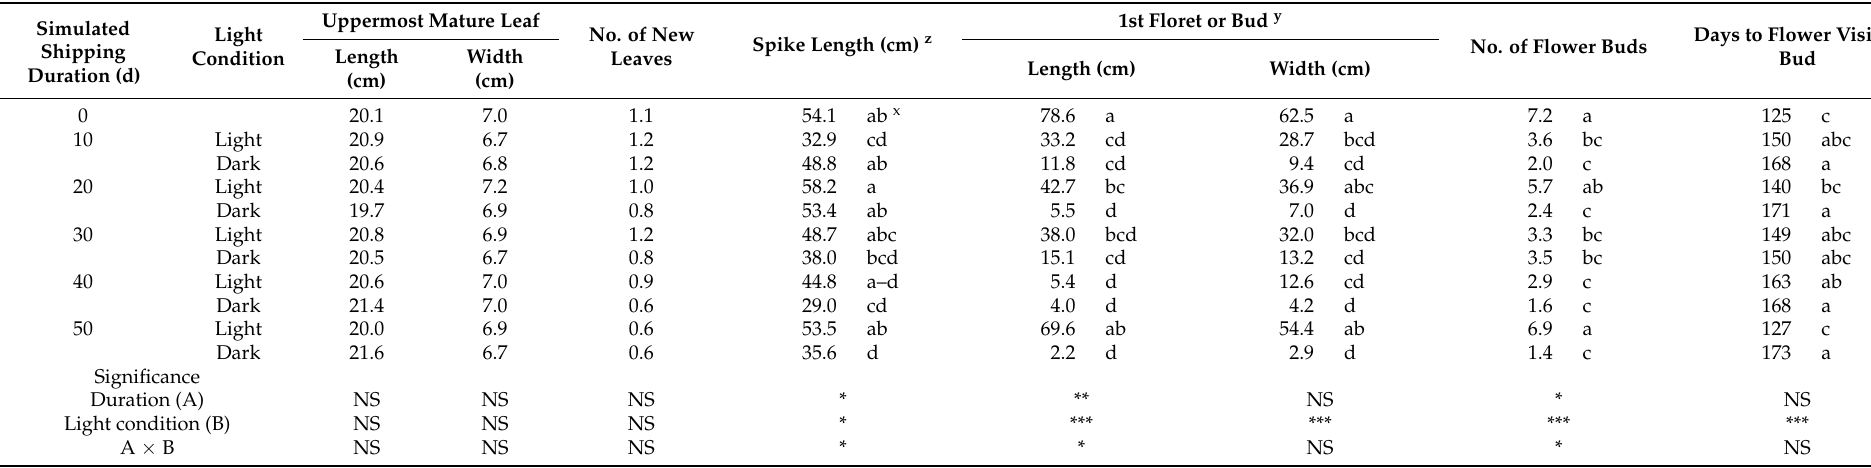
Table 1. Characteristics of the uppermost mature leaf and new leaf at 100 days after the start of simulated shipping and subsequent flowering quality of Phalaenopsis Sogo Yukidian ‘V3’. Simulated